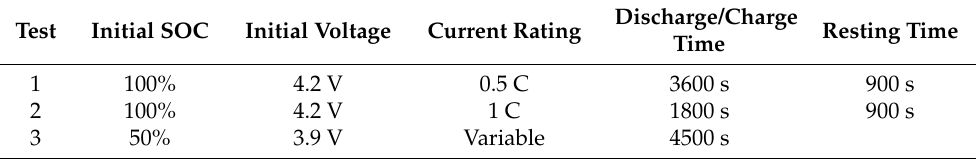
Table 3. Specifications of the investigated test cases for the